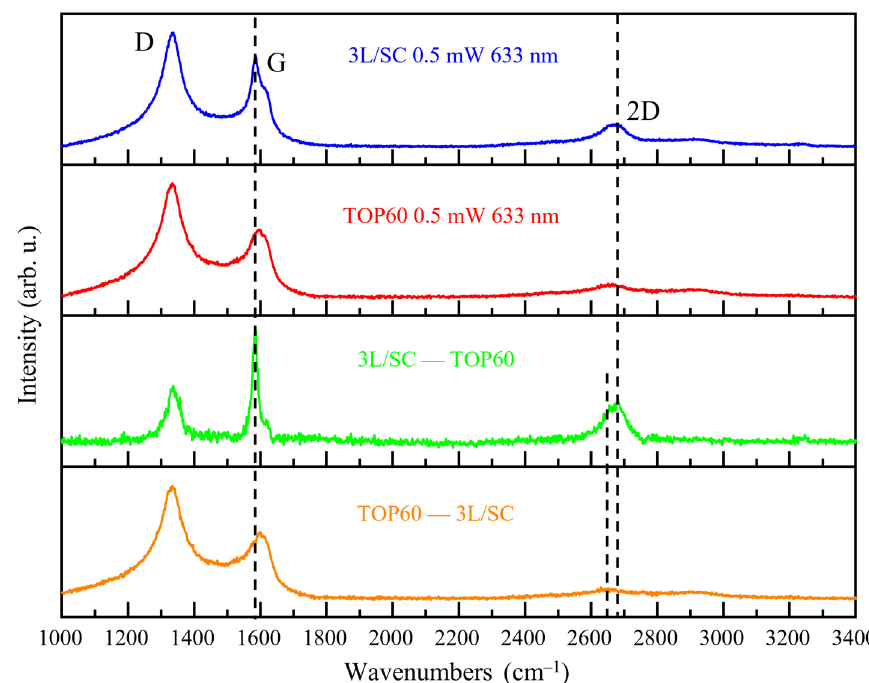
Figure 11. From the top to the bottom: Raman spectra of 3L/SC, TOP60, and subtraction spectra (3L/SC—TOP60) and (TOP60—3L/SC). Raman spectra were recorded with λ exc = 633 nm, with 0.5 mW laser power.